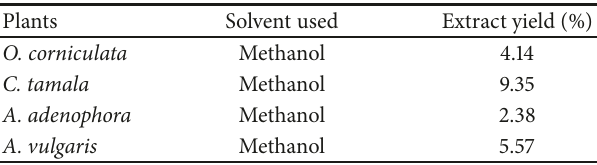
Table 2: Yield percentageof methanolicextractof plants used in the